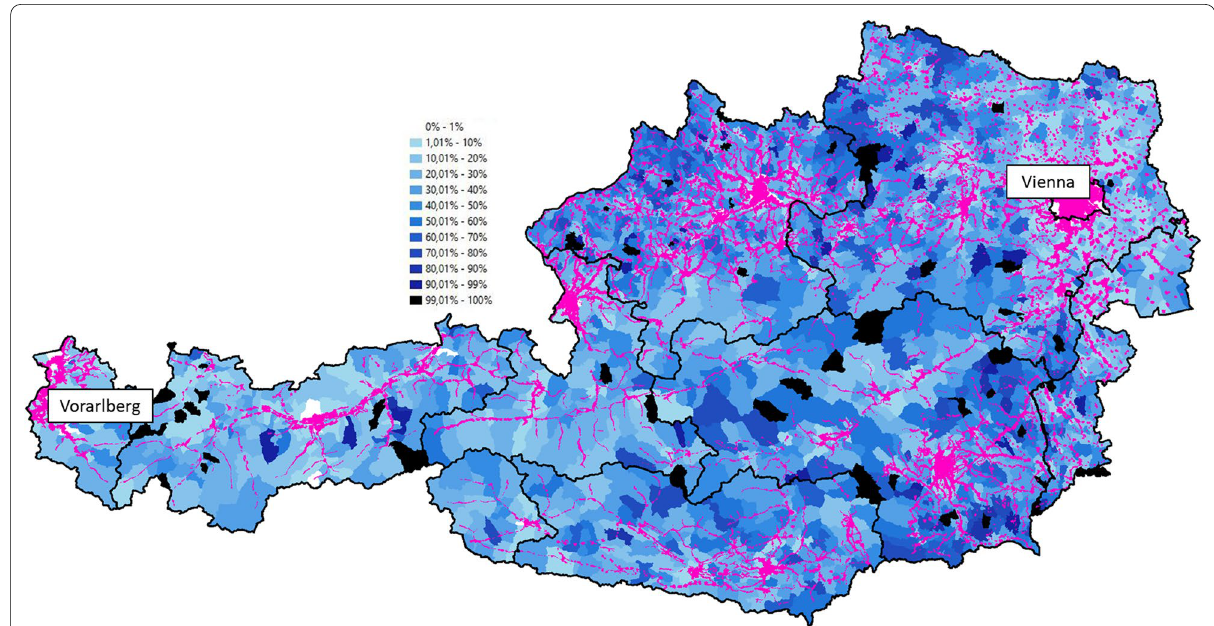
Fig. 1 Public transport (PT) coverage of inhabitants in Austria according to PTSQL, on a typical weekday. Pink areas are covered by SQL classes A-G, blue shaded areas show the share of inhabitants on municipality level that are not covered with PT according to PTSQL classes